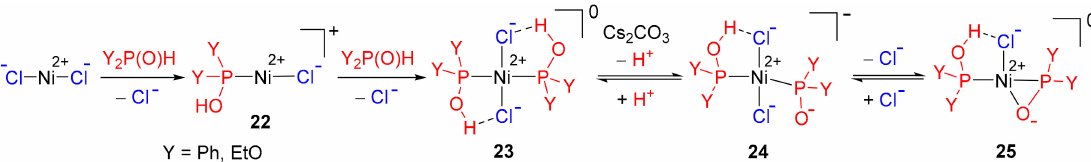
Scheme 11. Mechanism for the formation of the active catalyst from NiCl 2 and diphenylphosphine